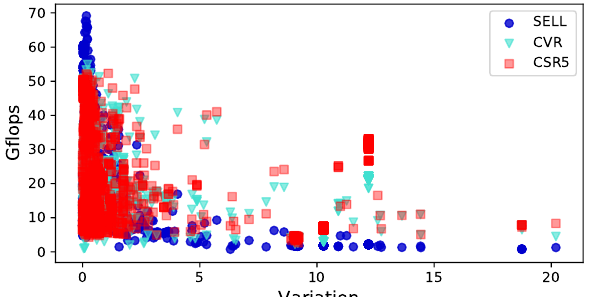
Figure 8. SpMV performance of SELL-8-512, CSR5, and CVR with matrices of different variations. The x-axis is variation ( vardata ), which represents the regularity of a given matrix. As var increases, the regularity degree of matrices decreases.